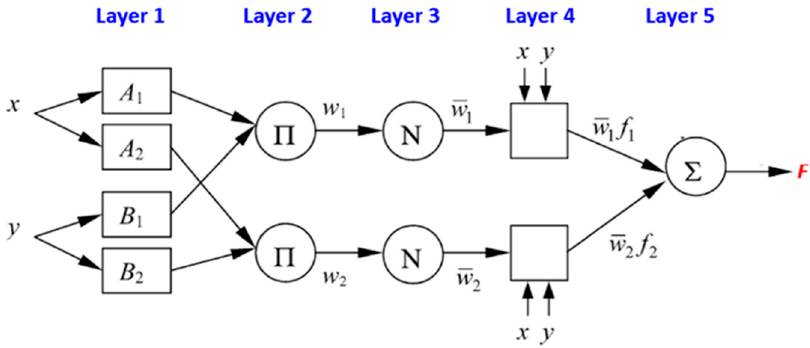
Figure 3. Schematic diagram of the two rule Sugeno system ANFIS architecture.